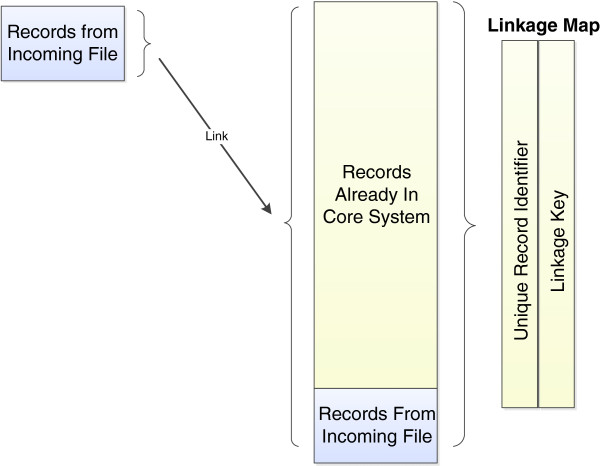
On-going linkage.